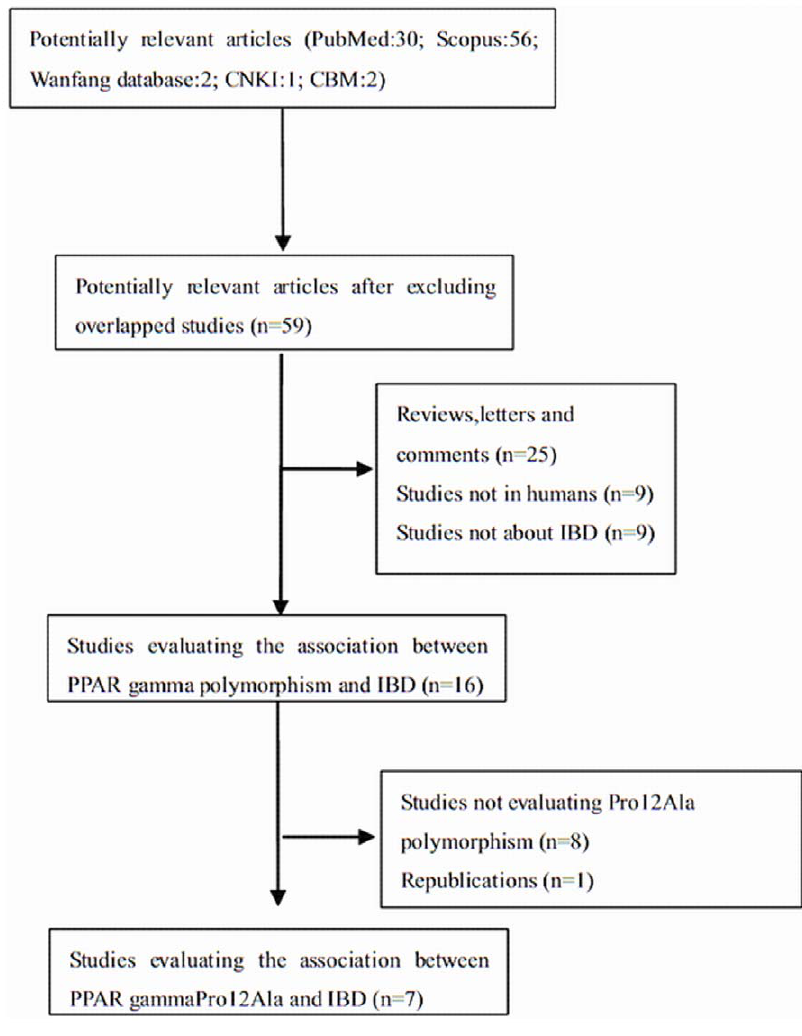
Figure 1. Flow diagram of the study selection process. doi:10.1371/journal.pone.0030551.g001 in Table 1 and Table 2. The PRISMA Checklist is shown in Text S1. The detailed searching process of Scopus is demonstrated in Text S2.